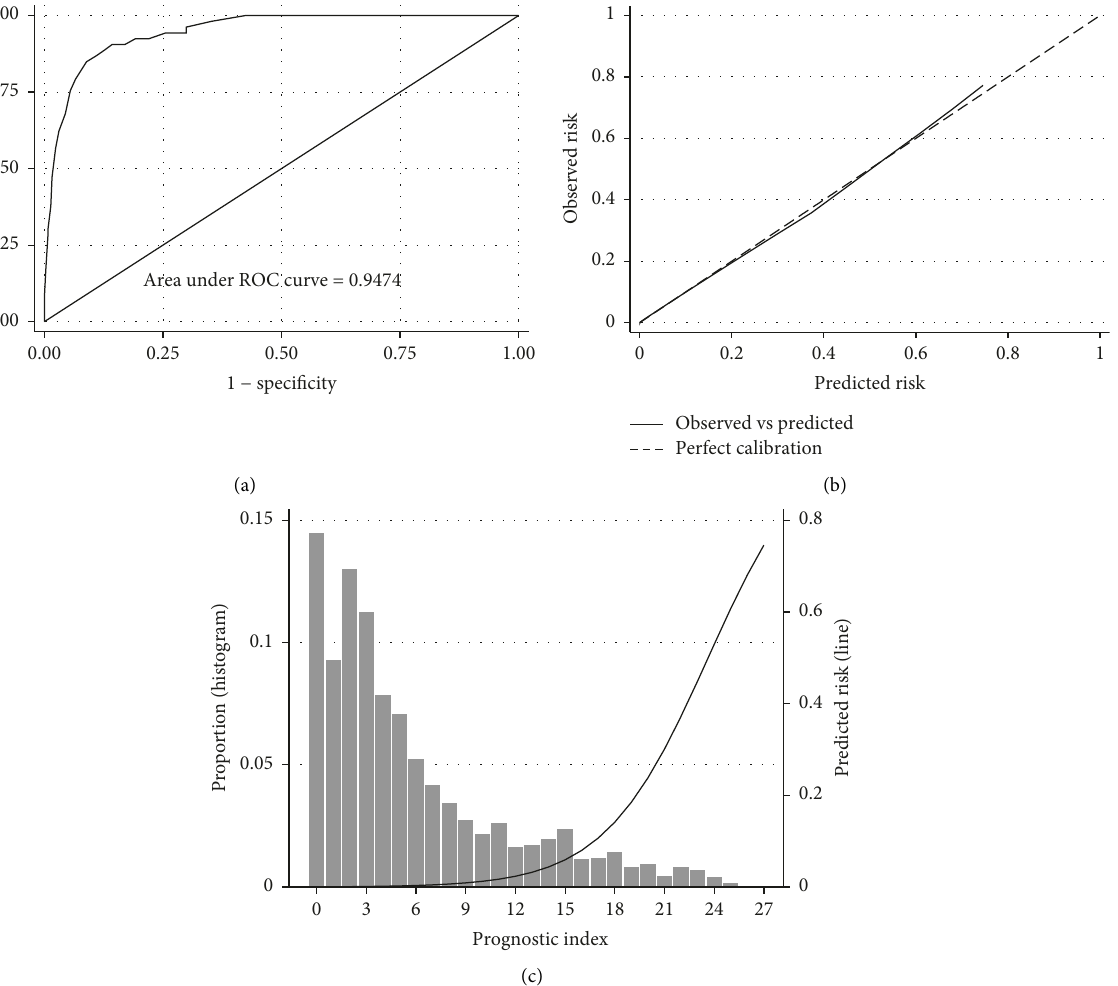
Area under ROC curve = 0.9474